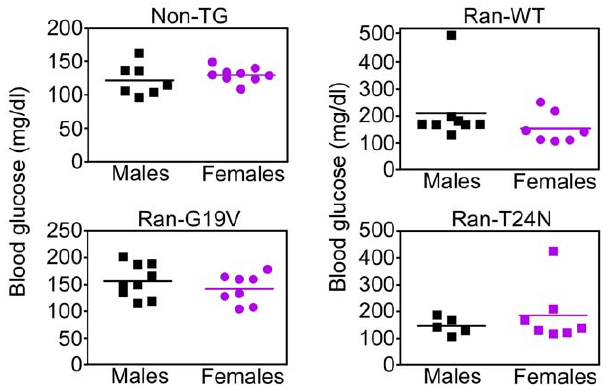
Figure 3. Gender analysis of the diabetic phenotype in Ran transgenic mice. The indicated non-TG or Ran transgenic mice were analyzed for gender differences in blood glucose levels at 2 mo of age. Each point corresponds to an individual